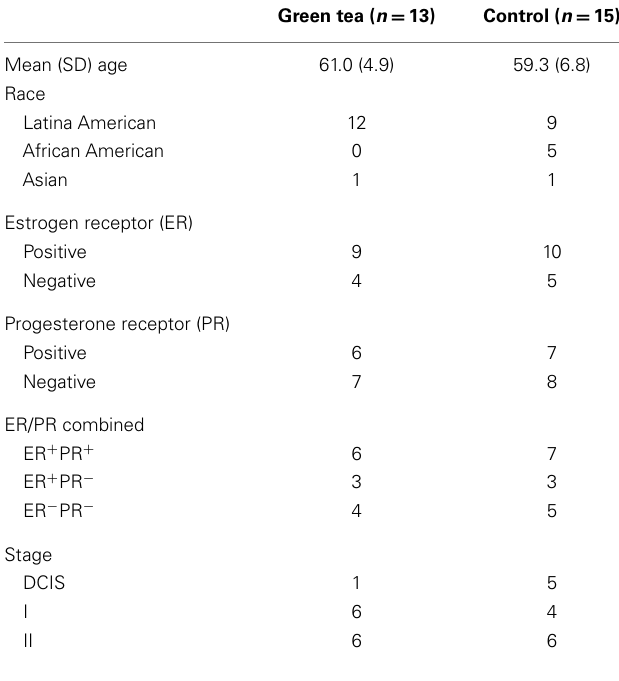
Table 1 | Demographic and clinical characteristics of study participants with diagnostic core biopsy and surgical specimen